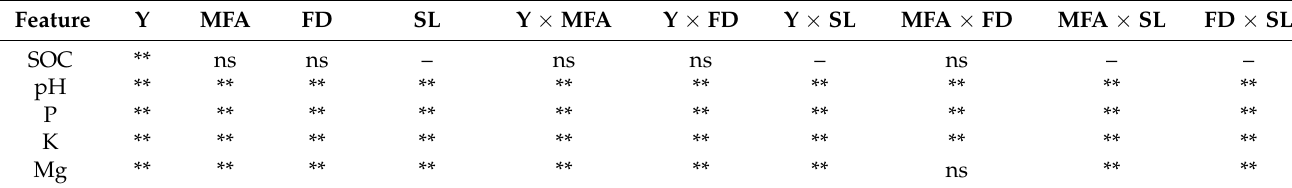
Table 4. Effect of years, method of fertilizer application, fertilizer dose, soil layer, and interaction of experimental factors on examined features.